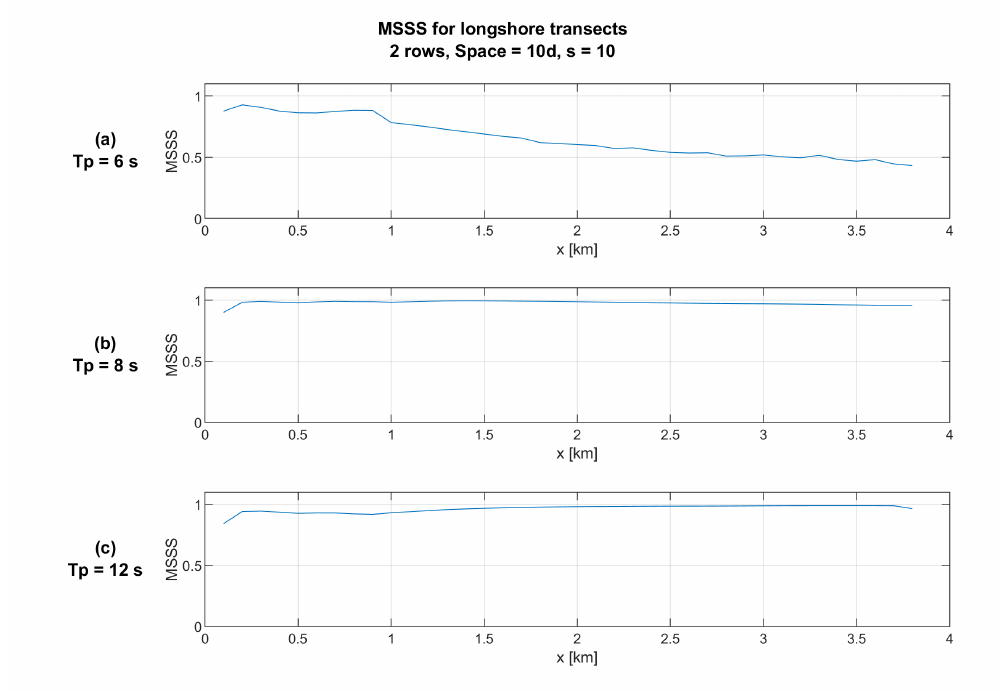
Figure 10. Mean-Squared Skill Score for longshore transects as a function of cross-shore location for the conditions given in Figure 8.